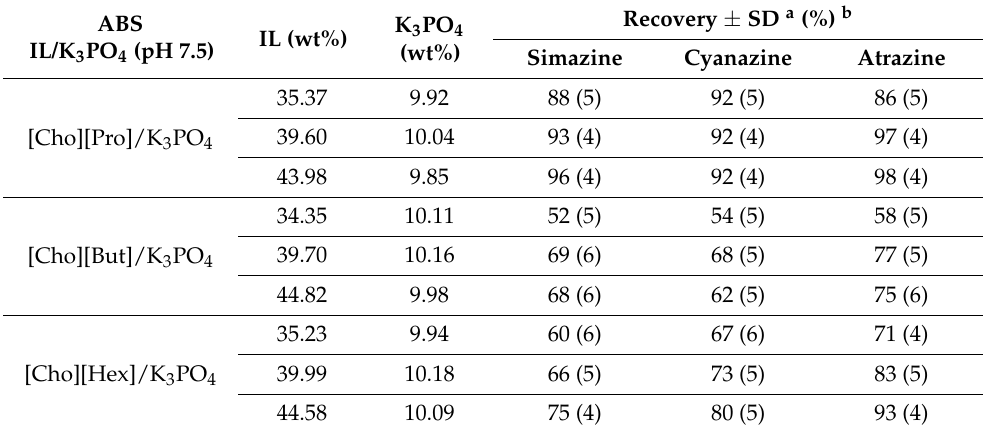
Figure 6. Binodal curves for ABS made with [Cho][Pro] ( ■ ), [Cho][But] ( ▼ ), and [Cho][Hex] ( ◆ ) and K 3 PO 4 at pH 7.5 (filled symbols) with the overall compositions used for the herbicides extraction (open symbols). Table 2. Extraction efficiency using the ABS composed of choline alkanoate IL + K 3 PO 4 + H 2 O at the same concentration of salt (pH 7.5).